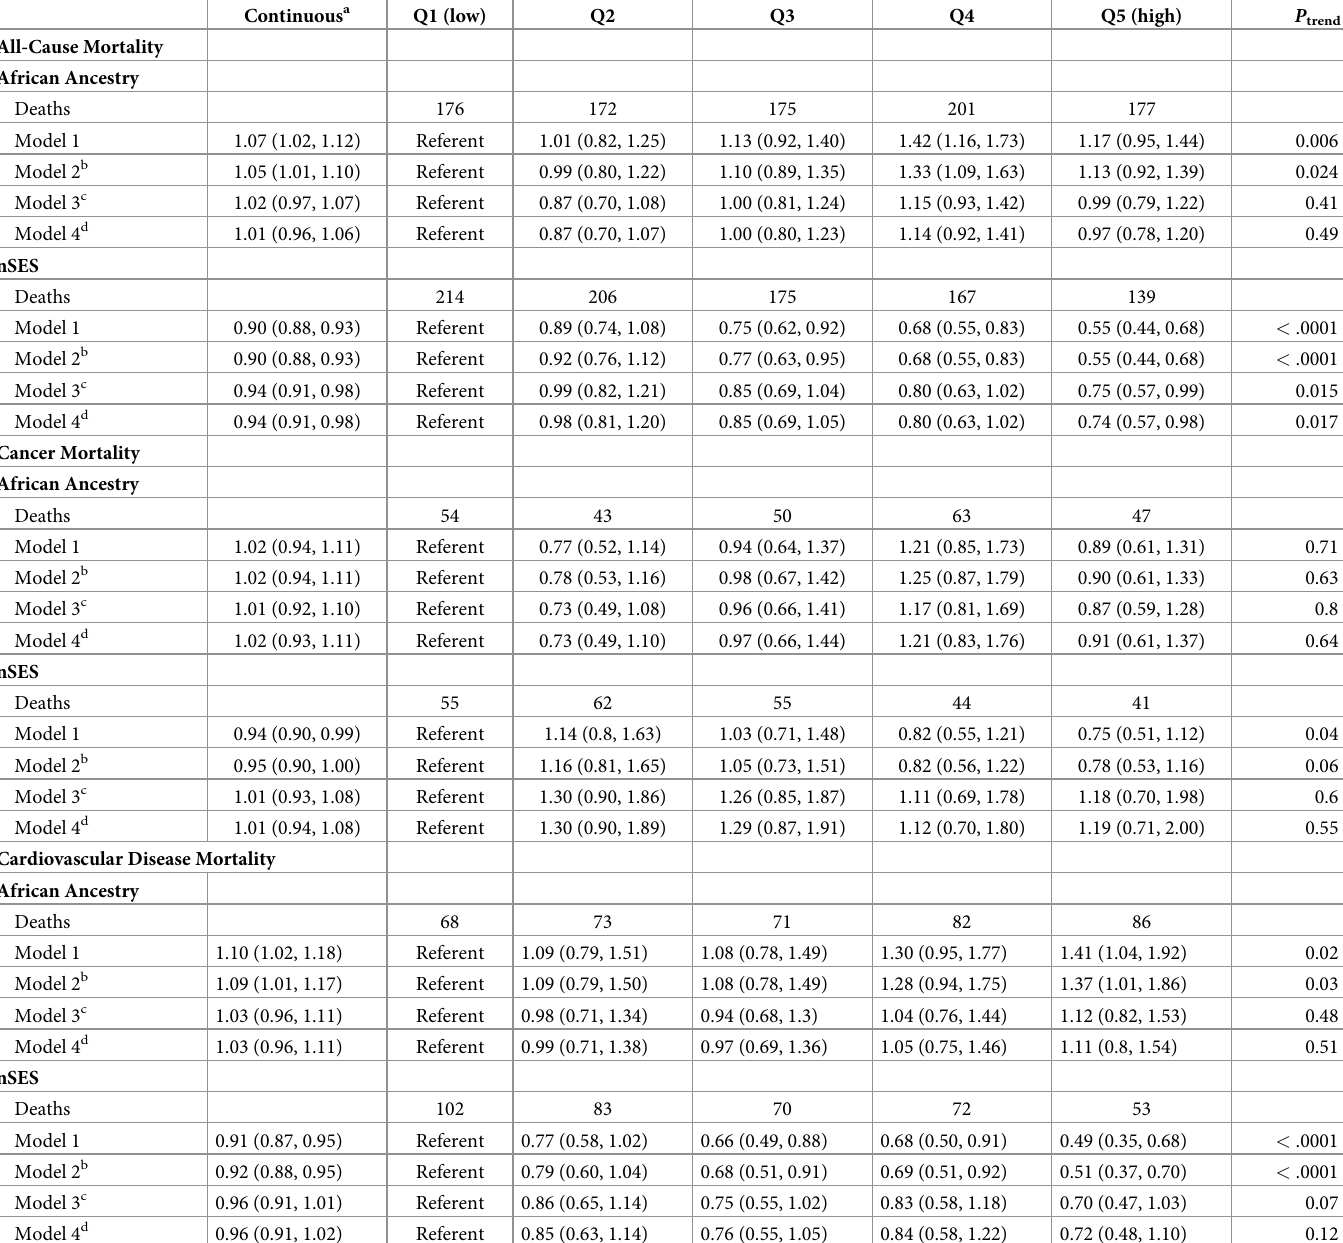
Table 2. Hazard ratios for association between quintile (Q) of African ancestry and neighborhood socioeconomic position (nSES) and mortality among self-identi- fied African American participants in the prostate, lung, colorectal, and ovarian cancer trial, United States, 1993–2019. Continuous a P